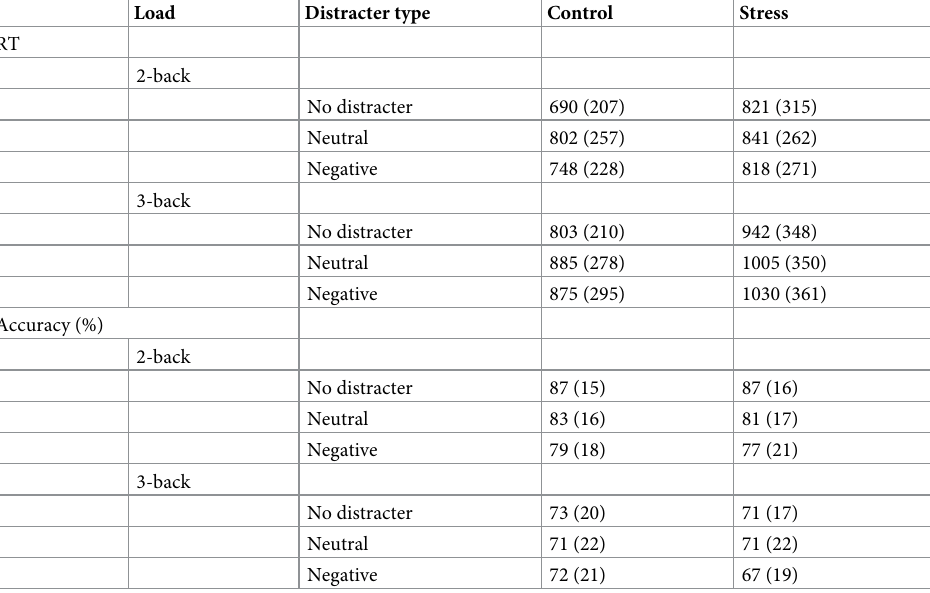
Table 2. Means (and standard deviations) of n -back performance for the control ( n = 41) and the stress groups ( n = 45). Load Distracter type Control Stress